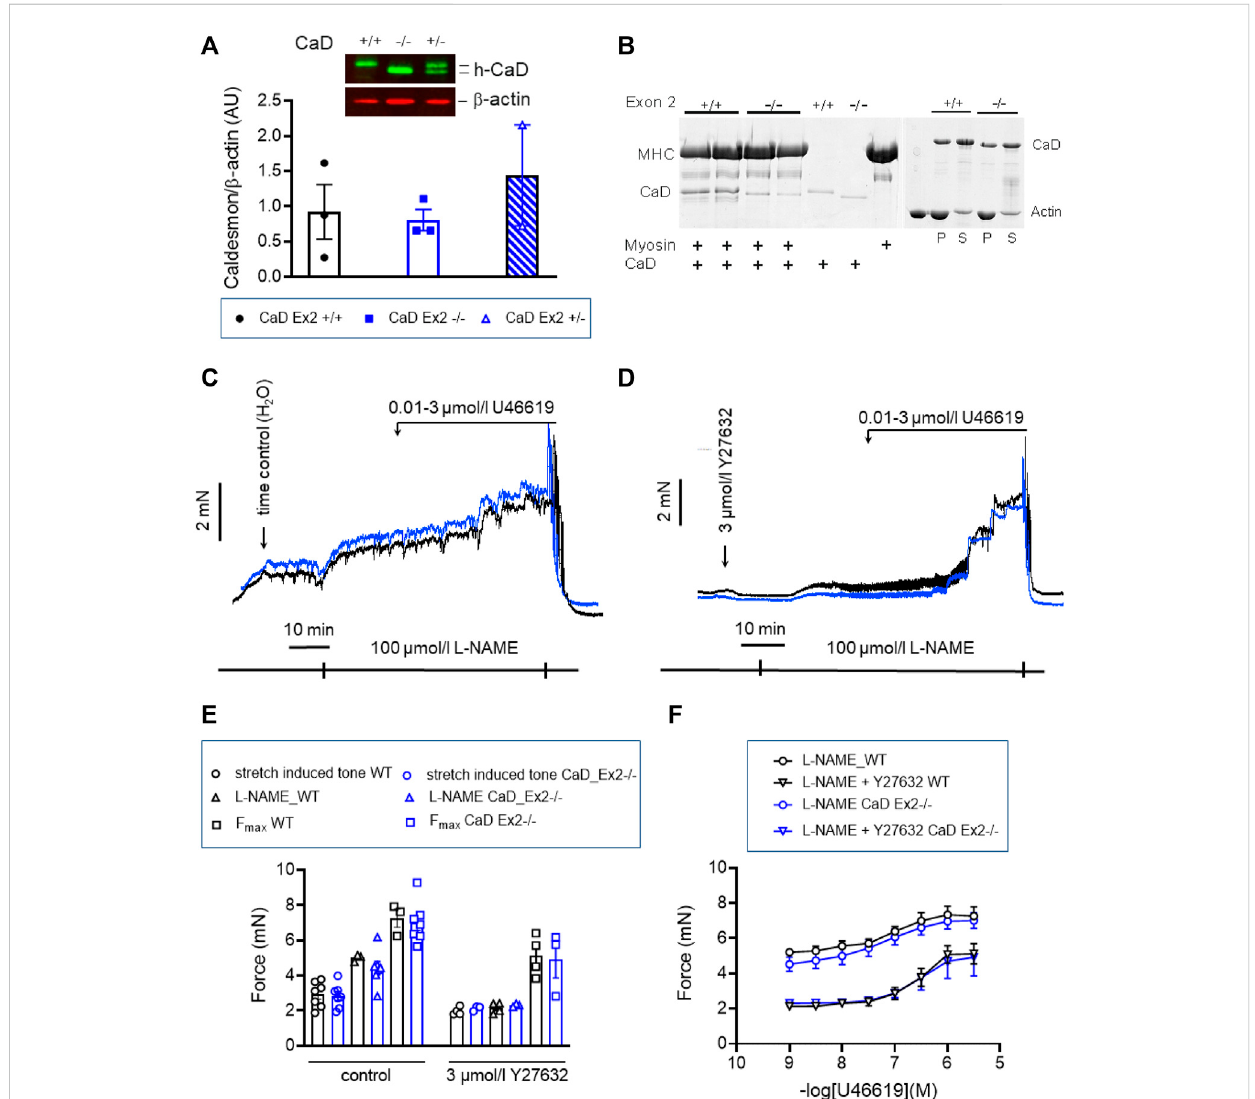
Effect of ablation of exon2 (Ex2) of Caldesmon on tone maintenance basilar arteries (A) Original luminogram and statistic evaluation showing caldesmonexpressionins-BAsobtainedfromwildtypeanimals,homozygousanimalslackingthestrongmyosin-bindingdomainofcaldesmonencoded by Exon 2 ( − / − ) and heterozygous animals (+/ − ) ( n = 3-3-2). (B) Analysis of two independent experiments con fi rming the lack of myosin binding of the truncated caldesmon isolated from Cald1 − / − mice (left panel), whereas actin-binding was not affected (right panel). (C,D) Original force tracings representing the effect of ablation of Exon2 in caldesmon protein on tone. (E) Left: Statistic evaluation of stretch-induced ( n = 7), L-NAME-induced ( n = 3 – 7), and maximal tone ( n = 3 – 7) in BAs from WT (CaD_ Δ Ex2 +/+) and CaD Δ Ex2 − / − BAs under control conditions. Right: Statistic evaluation of stretch- induced ( n = 4 – 3), L-NAME-induced ( n = 4 – 3), and maximal tone ( n = 4 – 3) in BAs from same groups in the presence of 3 μ mol/L Y27632. (F) Statistic evaluation of tone induced by cumulative application of U46619 ( n = 6 – 4). Data represented as absolute force